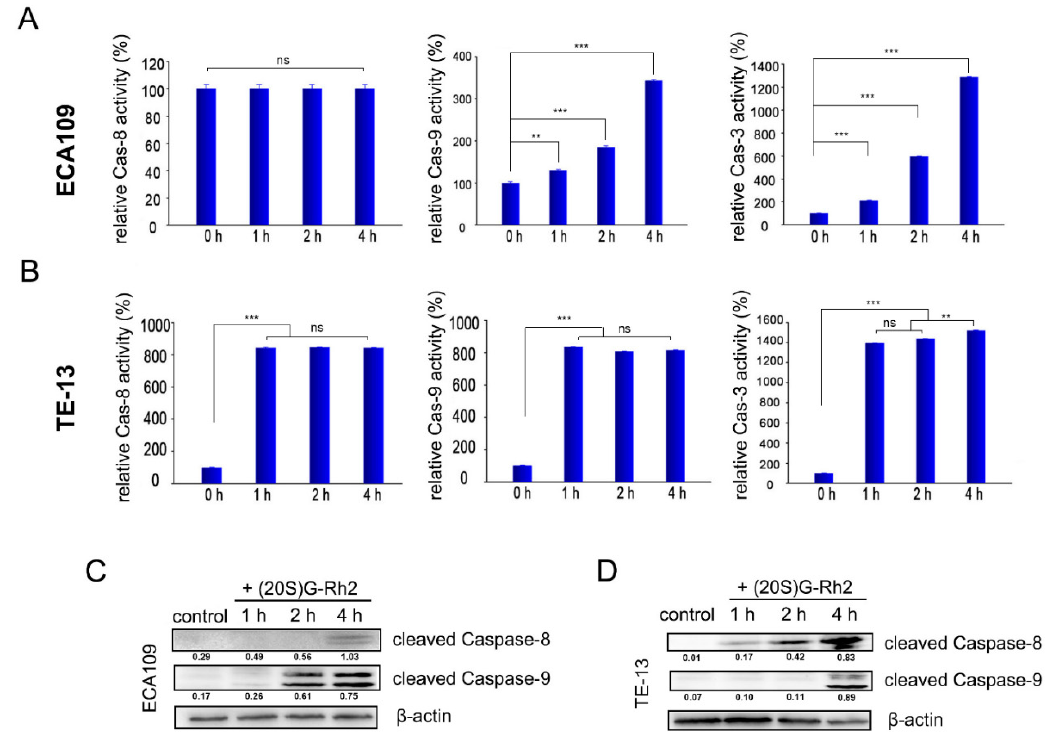
Figure 3. ( A , B ) Activity assay of Caspase-8, Caspase-9, and Caspase-3 in ECA109 and TE-13 cells. Cells were treated with 7.5 µ g/mL G-Rh2 for the indicated times. Cell-free Caspase-8, -9, and -3 activities were detected by using specific substrates: Ac-IETD-AFC (for Caspase-8), Ac-LEHD-AFC (for Caspase-9), and Ac-DEVD-AFC (for Caspase-3); ( C , D ) Western blot results of cleaved Caspase-8 and cleaved Caspase-9 in ECA109 and TE-13 cells after being treated with (20S) G-Rh2. ** p < 0.01, *** p < 0.001 .